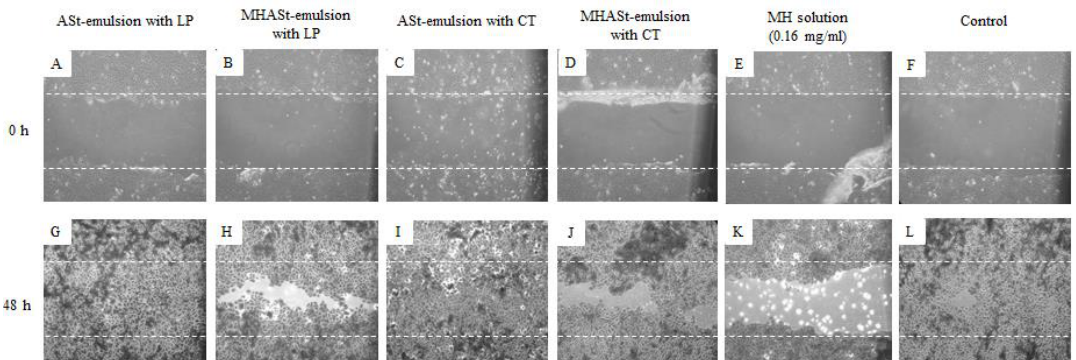
Figure 4. Representative time-lapse images of HaCaT keratinocyte scratch assays immediately after the scratches had been made and then after 48 h in the presence of 5%-emulsions with LP ( A , G ), 5%-MHASt-emulsions with LP ( B , H ), 5%-ASt-emulsions with CT ( C , I ), 5%-MHASt-emulsions with CT ( D , J ), MH solution ( E , K ) or control medium ( F , L ). The cells were allowed to migrate for 48 h, fixed and photographed. Outlines of the original wounds are marked with dashed lines. Original magnification 40×.